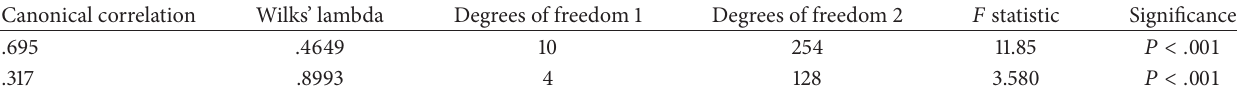
Table 2: Canonical